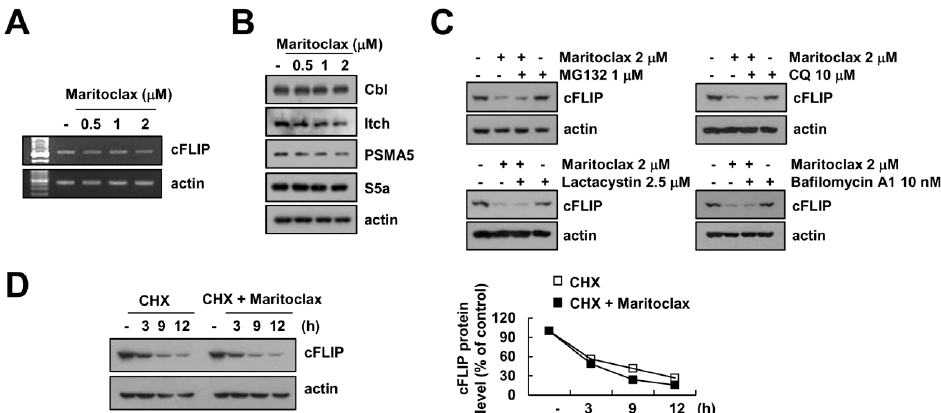
Figure 5. Maritoclax-induced cFLIP downregulation is not associated with proteasomal pathway. ( A , B ) Caki cells were treated with indicated concentrations of maritoclax for 24 h. The mRNA level was determined by RT-PCR ( A ). The protein expression levels were determined by Western blotting ( B ). ( C ) Caki cells were pretreated with proteasome inhibitors (1 µ M MG132 and 2.5 µ M lactacystin) and lysosomal inhibitors (10 µ M chloroquine (CQ) and 10 nM bafilomycin A1) for 30 min, and then treated with 2 μ M maritoclax for 24 h. The protein expression levels were determined by Western blotting. ( D ) Caki cells were treated with or without 2 μ M maritoclax in the presence of 20 μ g/mL cycloheximide (CHX) for the indicated time periods. The protein levels were determined by Western blotting (left panel). The band intensity of the cFLIP protein was measured using ImageJ (public domain JAVA image-processing program; http://rsb.info.nih.gov/ij, right panel). − , no treatment; +, treatment. Molecules 2018 , 23 , x FOR PEER REVIEW